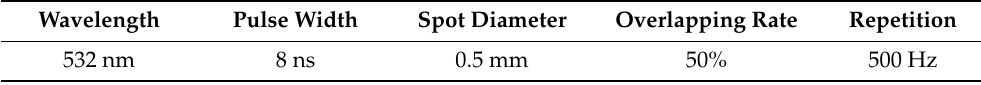
Figure 2. Schematic of ( a ) Micro-LSP process, ( b ) sample after strengthening, ( c ) “Z” pattern. Table 2. Detailed parameters of the Micro-LSP process.